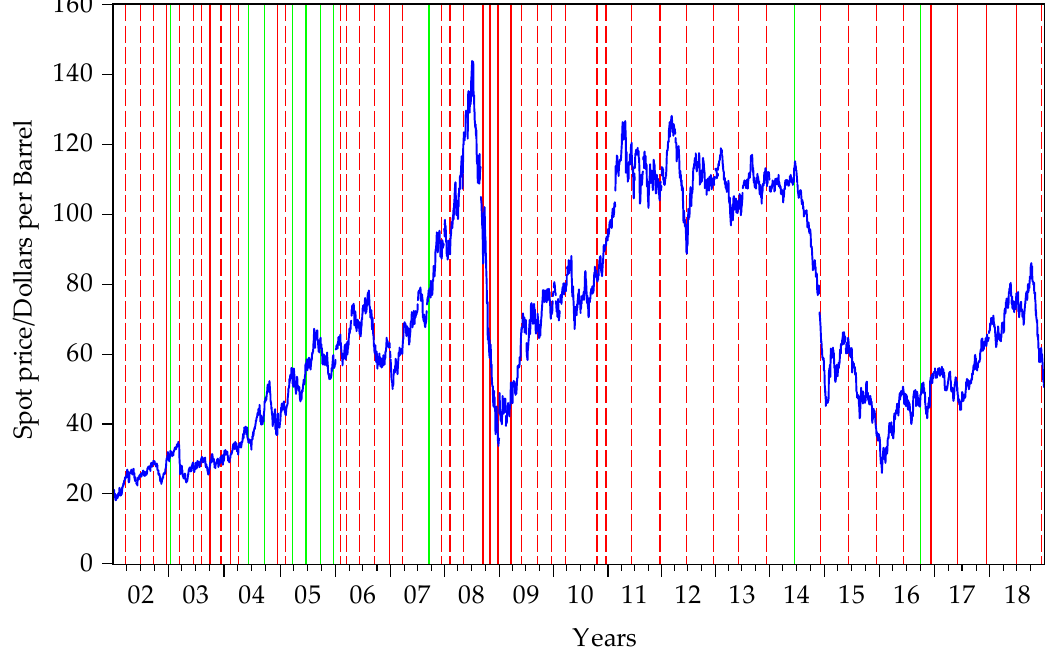
Figure 2. Brent spot prices and OPEC’s announcements. The solid, red line represents the “cut decision”, the green line shows the “increase decision”, and the dotted, red line depicts the “maintain decision”.